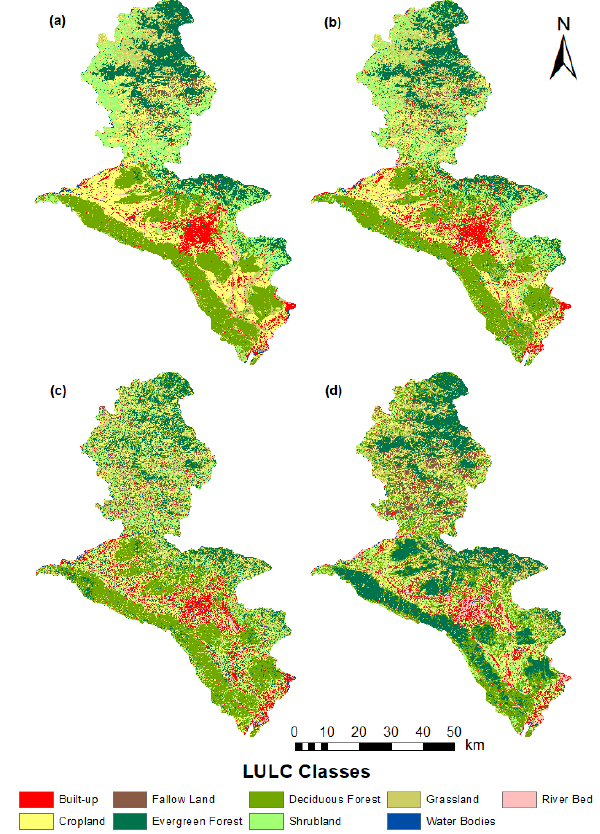
Figure 8. Land cover maps obtained using different Maximum Likelihood (ML) classifiers from dataset D-2: ( a ) RF classifier, ( b ) CART classifier, ( c ) SVM classifier, and ( d ) RVM classifier. Training samples of 700 pixels per class obtained using SRS(Eq) method are used for land cover classification.